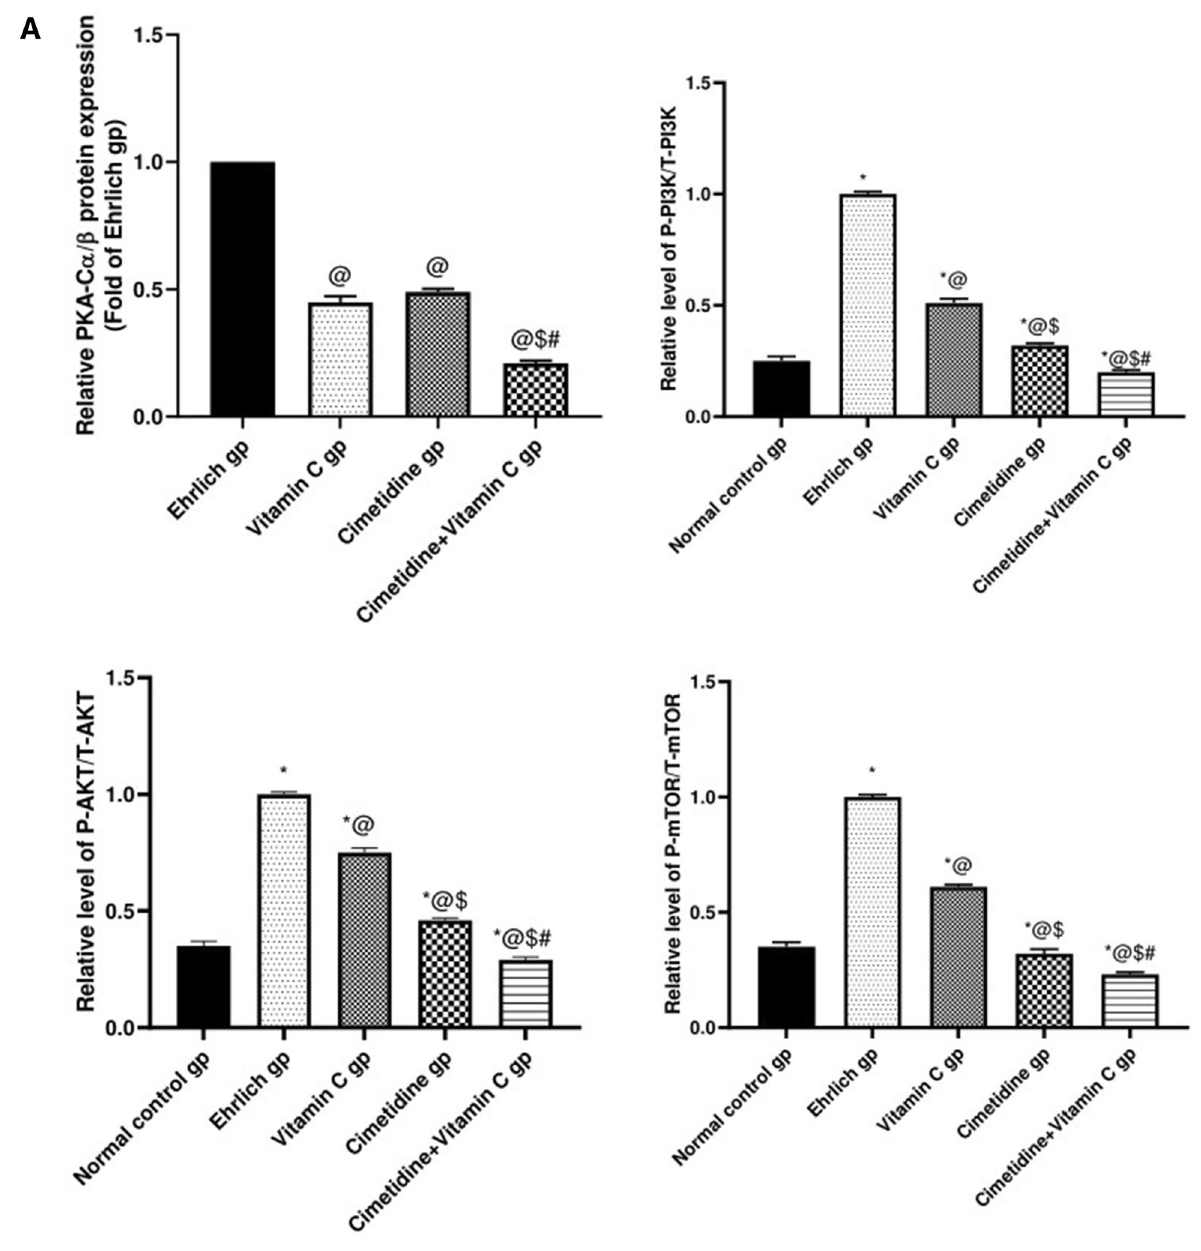
Figure 11. The changes in the PKA-C α/β, total and phosphorylated PI3K, AKT, mTOR expression levels after treatment with cimetidine at a dose of 200 mg/kg/day, vitamin C at a dose of 4 g/kg/day, and their combination for 15 days after Ehrlich induction of breast cancer in mice. Data are presented as mean ± SD.* is significantly different from the normal control group, P < 0.05. @ is significantly different from Ehrlich untreated group, P < 0.05. $ is significantly different from the vitamin C-treated group, P < 0.05. # is significantly different from cimetidine-treated group, P <